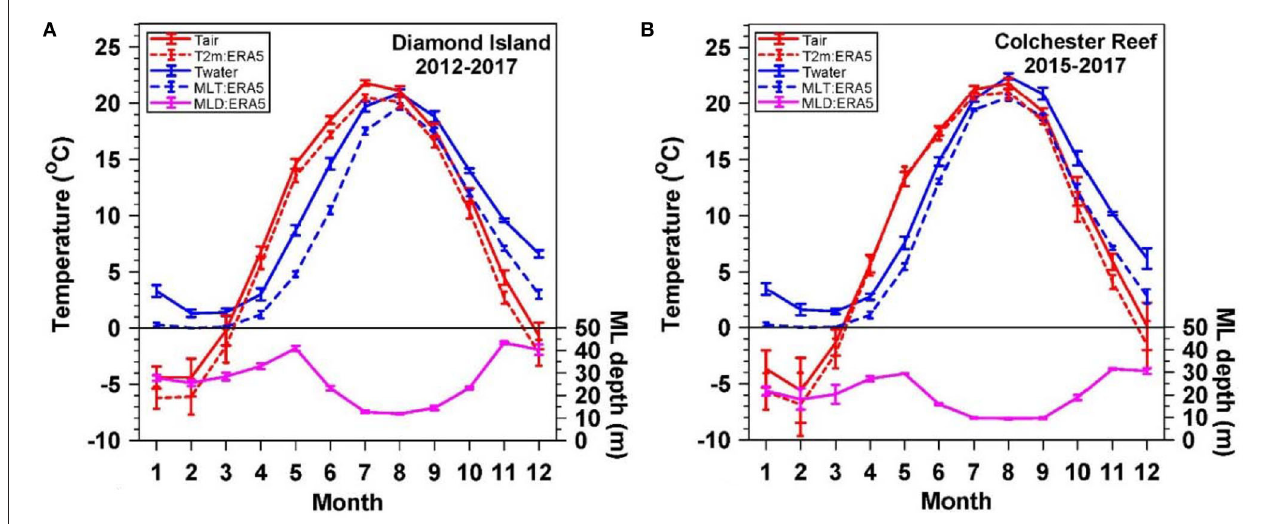
FIGURE 3 | (A) Mean annual cycle of T air , T2 m , T water , MLT, and MLD for Diamond Island and (B) Colchester Reef (right).